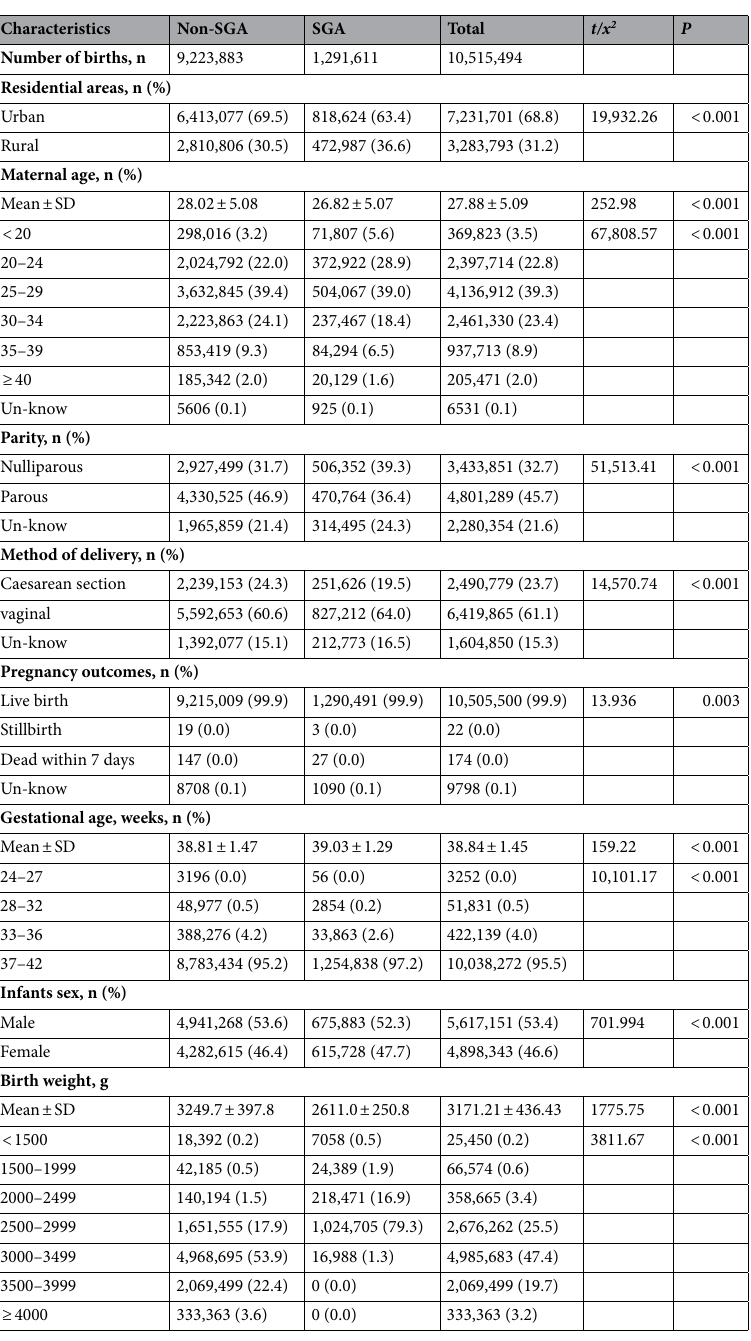
Table 2. Percentage of SGA and non-SGA across different groups stratified by characteristics of mothers and